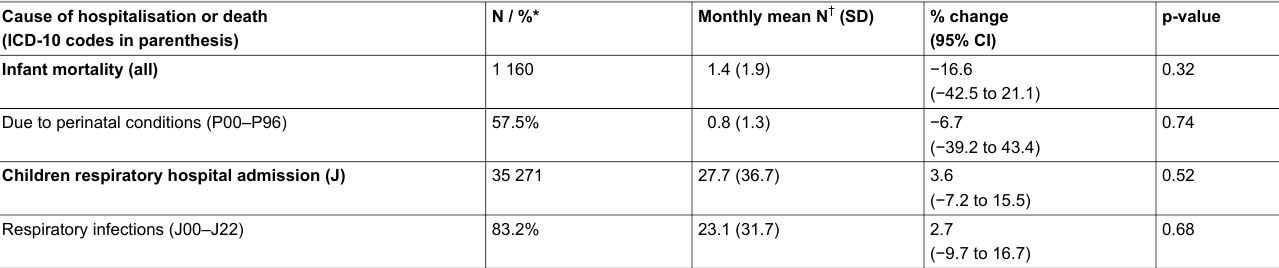
Table S6: Description of the children included and estimates of change in risk after the introduction of the smoking ban in infant mortality (<1 year of age) and respiratory hospital admission in children (≤15 years) (series restricted to period of 2 years before and 2 years after the introduction of the smoking ban in each canton). Cause of hospitalisation or death (ICD-10 codes in